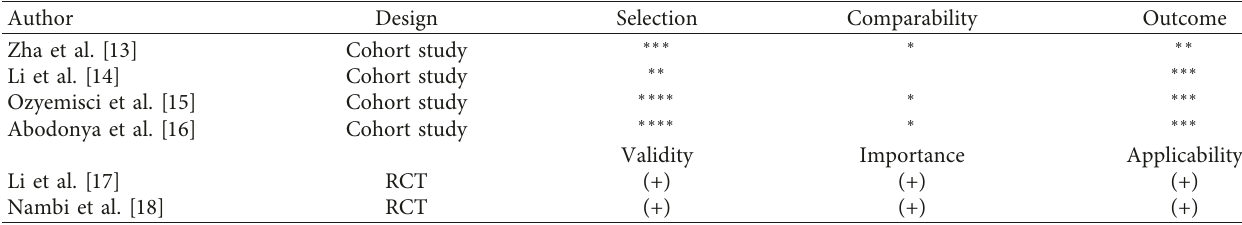
Table 3: Critical appraisal of eligible